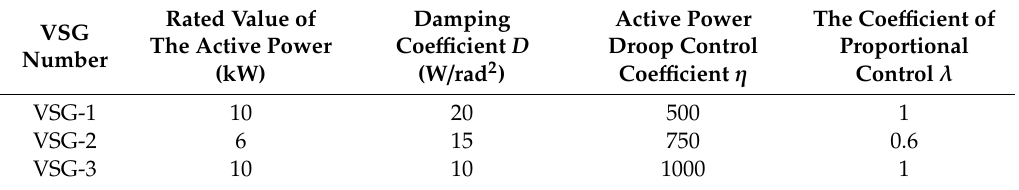
Table 4. Part of simulation parameters.